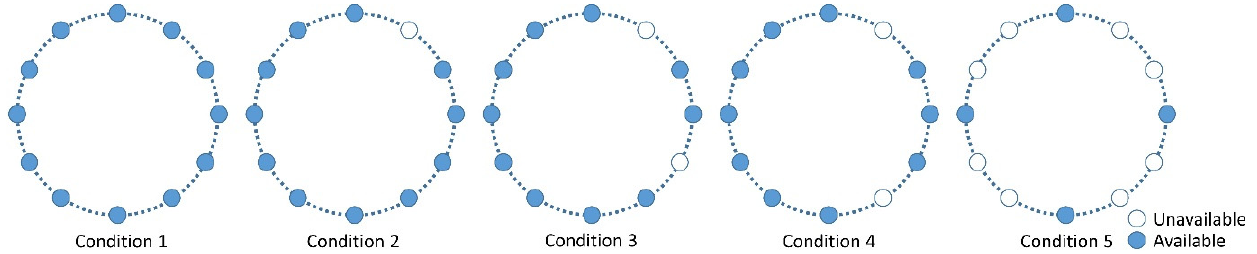
Figure 2. Conditions of unavailable records in the SMART 1 record.